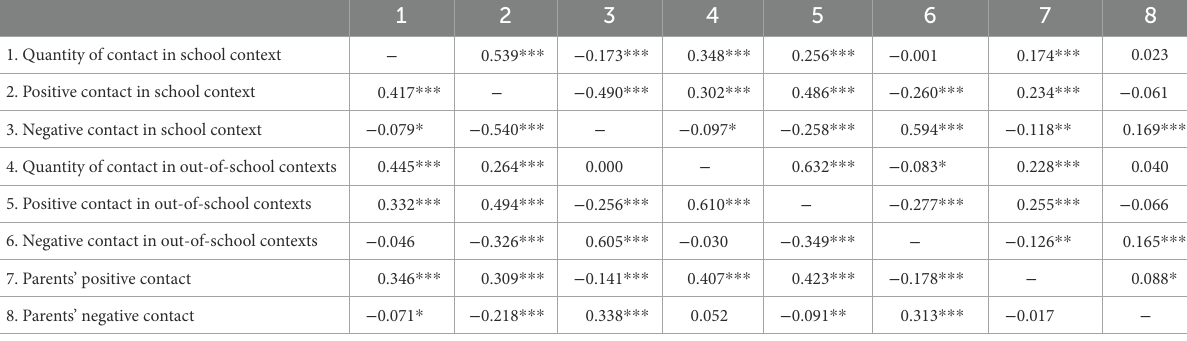
TABLE 5 Bivariate correlations among variables in studies II (in Italy) and III (in